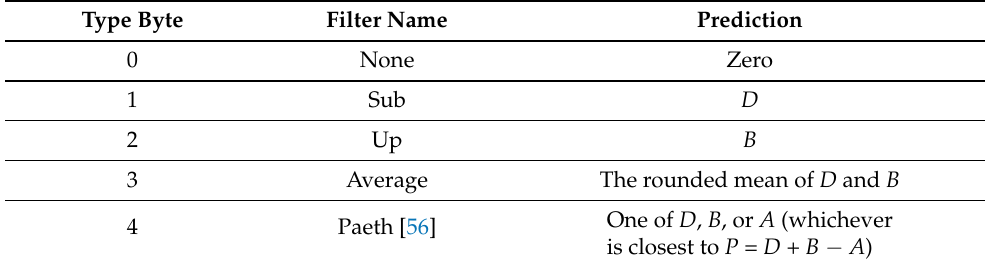
Table 4. Predictor for Portable Network Graphics (PNG)-based image